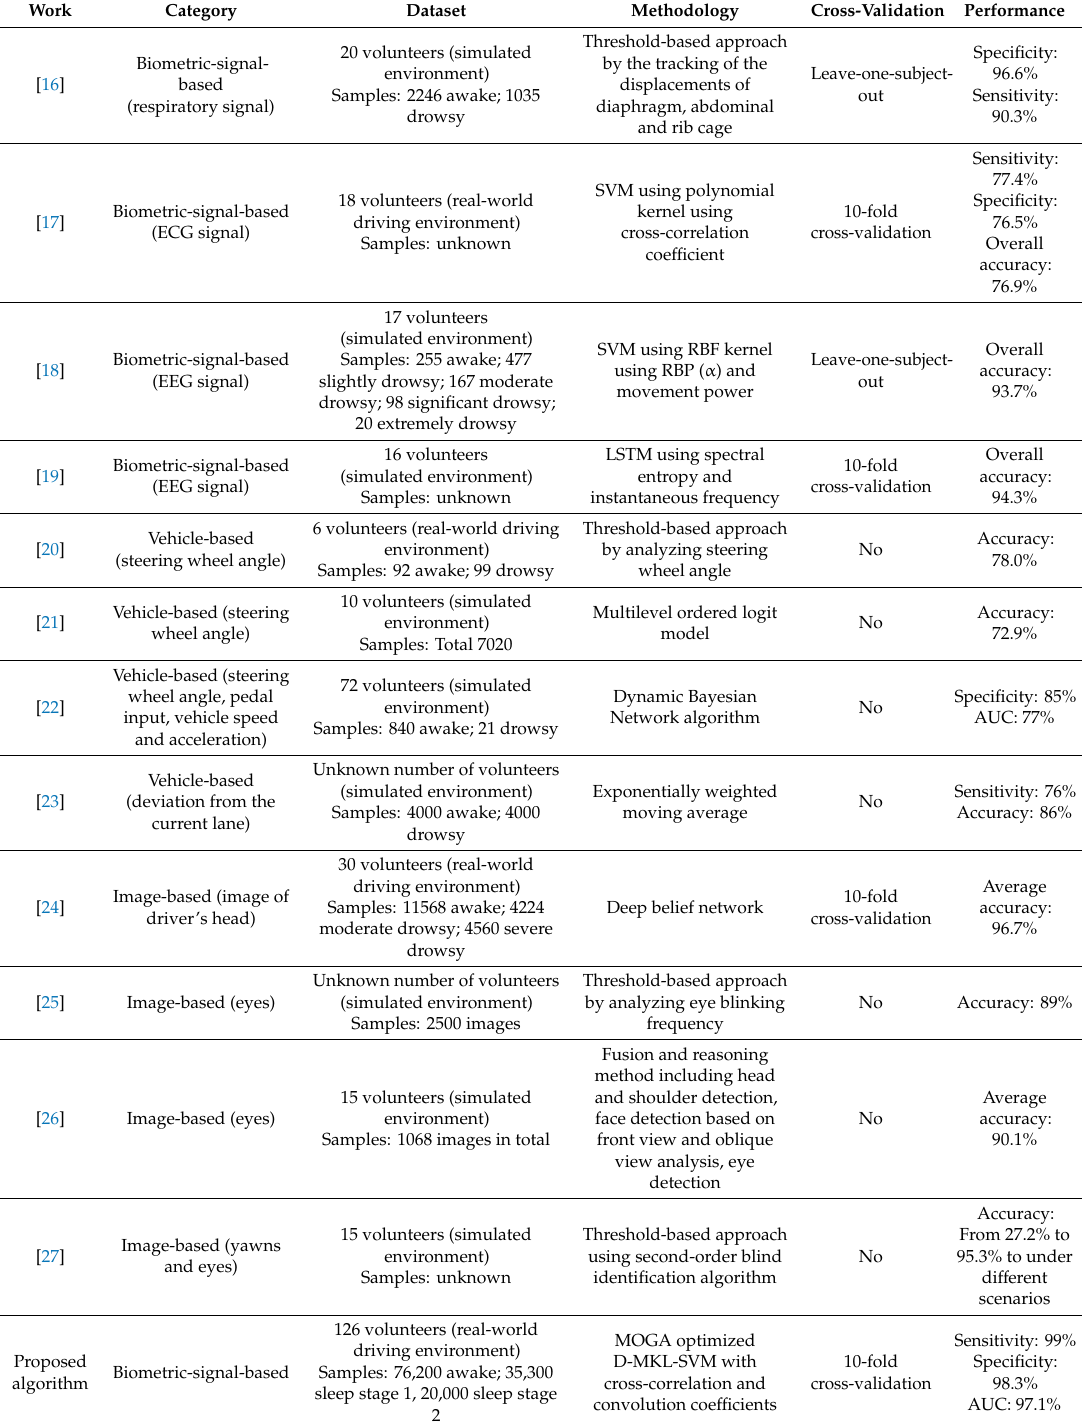
Table 2. Performance comparison between the proposed method and existing works for driver drowsiness